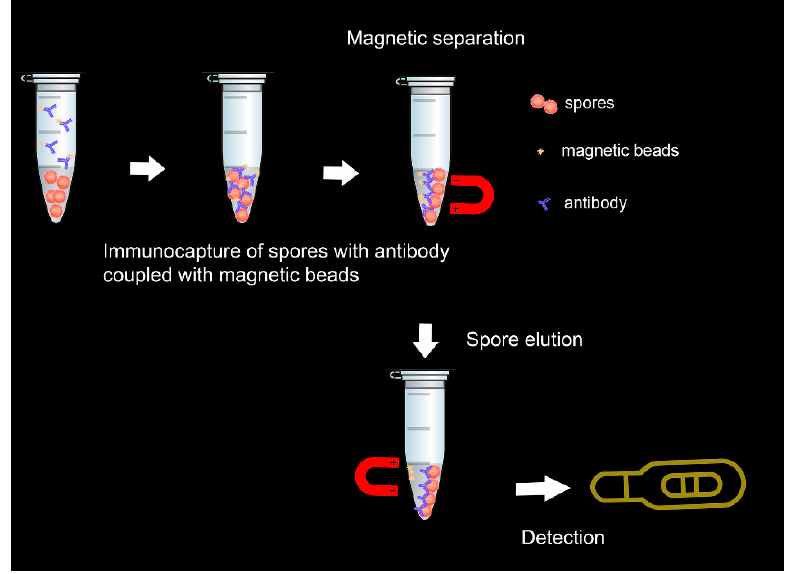
Figure 3. Illustration of the immunomagnetic lateral flow sensing principle.